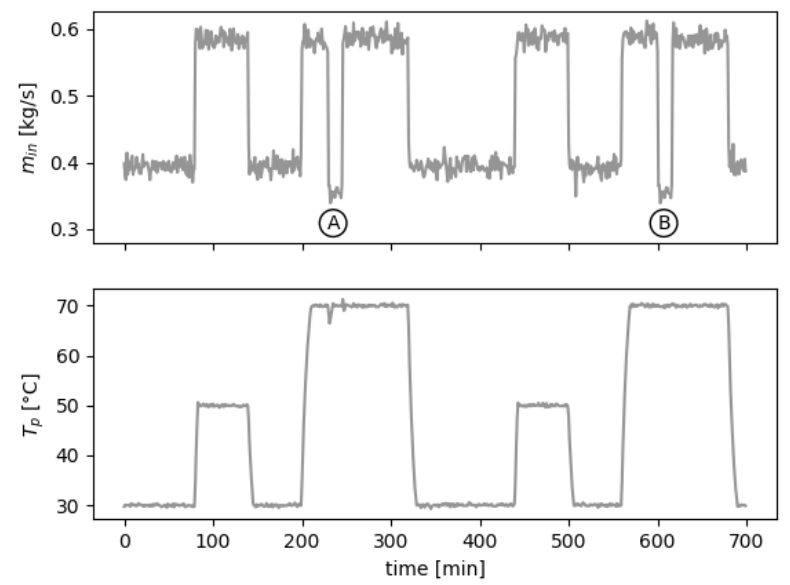
Figure 12. Scenarios: sensor fault (“A”) and clogged duct (“B”).